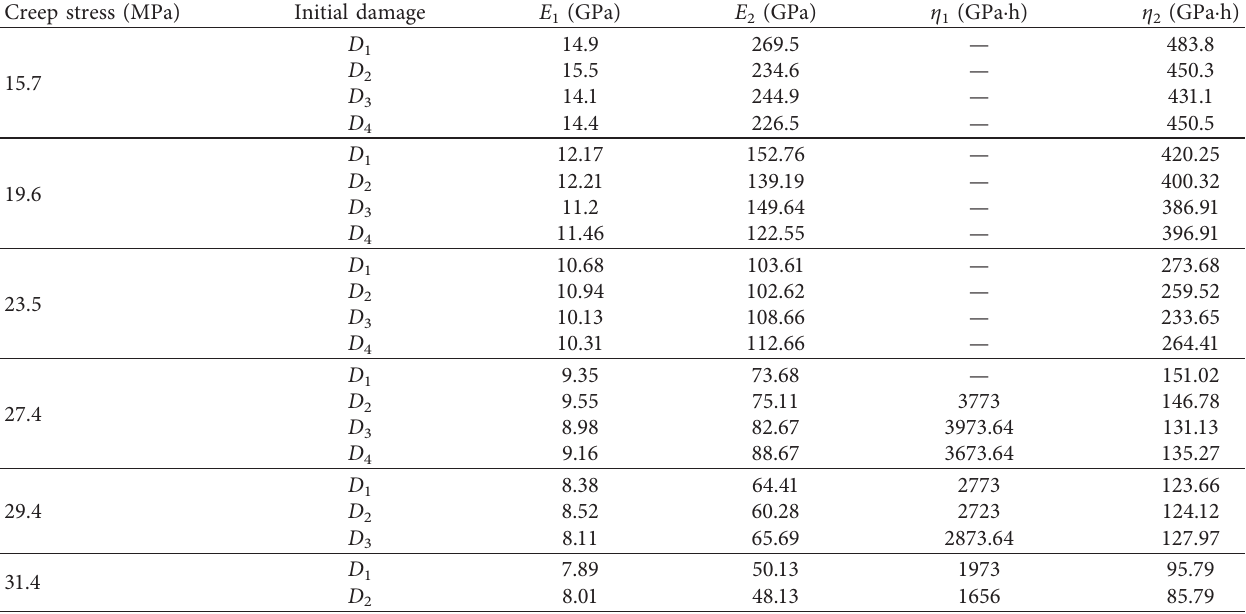
Table 6: Creep parameters of rock specimens with different initial damage